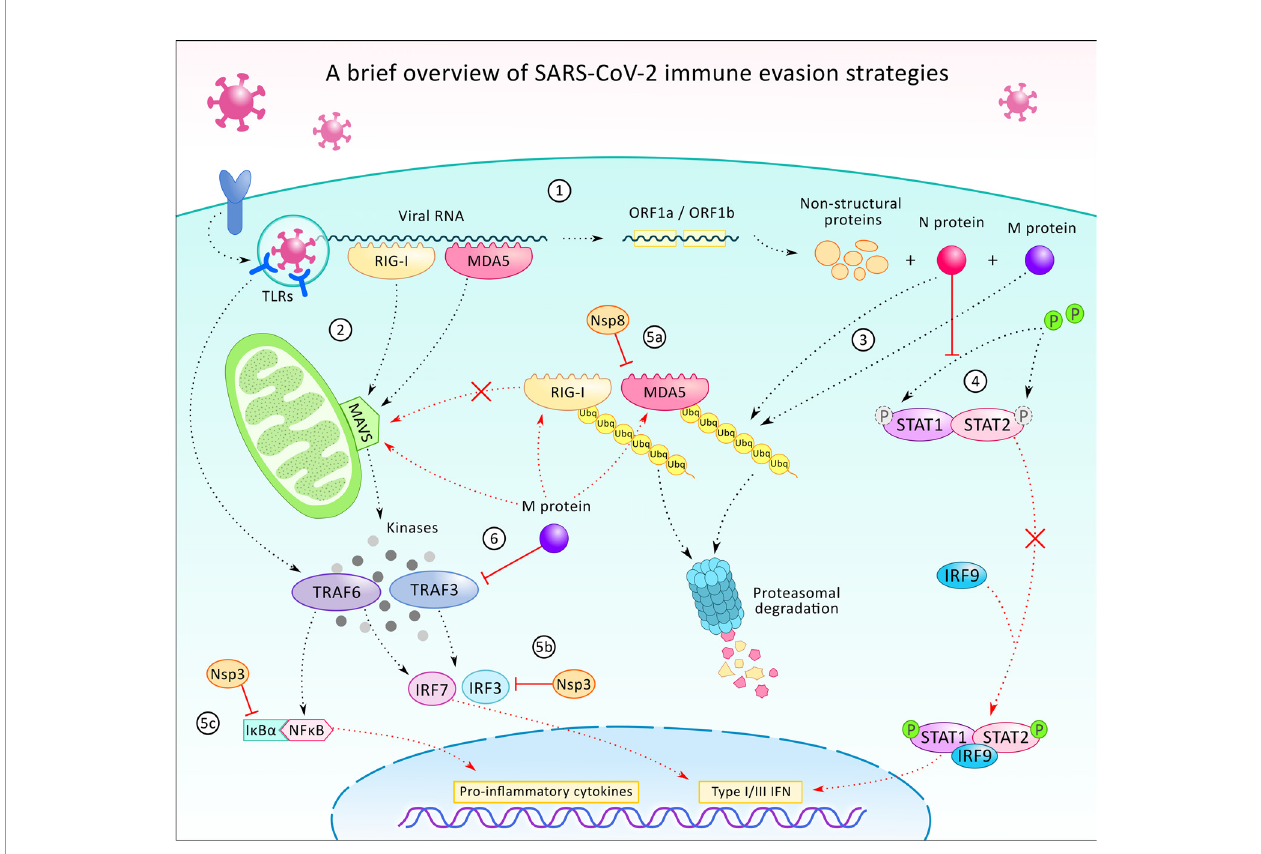
FIGURE 3 | A brief overview of the SARS-CoV-2 virus ’ immune evasion strategies. After infecting the host cell, the internalization of the viral particle, the transcription of the viral RNA starts with the translation of ORF1a and ORF2b, which generates proteins participating in the further transcription, host modulation, and immune evasion (1). In the cell, the presence of viral particles or viral RNA is being recognized by pattern recognition receptors such as toll-like receptors (TLR), retinoic acid-inducible gene I (RIG-1), and melanoma differentiation-associated protein 5 (MDA5) (2). TLRs (TLR 3, 7, and 8) are localized on endosomes and together with the cytoplasmatic viral sensors RIG-1 and MDA5, which orchestrate the translocation of NF- k B and IRF3 to the nucleus, leading to the expression of pro-in fl ammatory cytokines and type 1 and 3 interferons (INF-1/3). While TLRs activate TNF-associated factor 6 (TRAF6), RIG-1 and MDA5 act through mitochondrial antiviral protein (MAVS), to TRAF3/6, to IRF3/7. Viral protein N and M can alter the ubiquitination and degradation of RIG-1 and MDA5 sensors (3), thus restrains the activation of MAVS, TRAF3/6, and prevents IRF-3/7 and NF- k B signaling. N protein can also counteract IFN-1 production by inhibition of signal transducer and activator of transcription protein 1 and 2 (STAT1/2) phosphorylation and activation for further signaling (4). Additionally, some of the non-structural proteins (Nsp3, 8 and others - not shown) can also execute immunomodulatory functions, such as contributing to the inhibition of MDA5 (5a), IRF3 (5b), or stabilizing the NF- k B inhibitor I k B a (5c). Viral protein M also participates in immune evasion by blocking TRAF3 and binding to RIG-1, MDA5, and MAVS and preventing their interaction